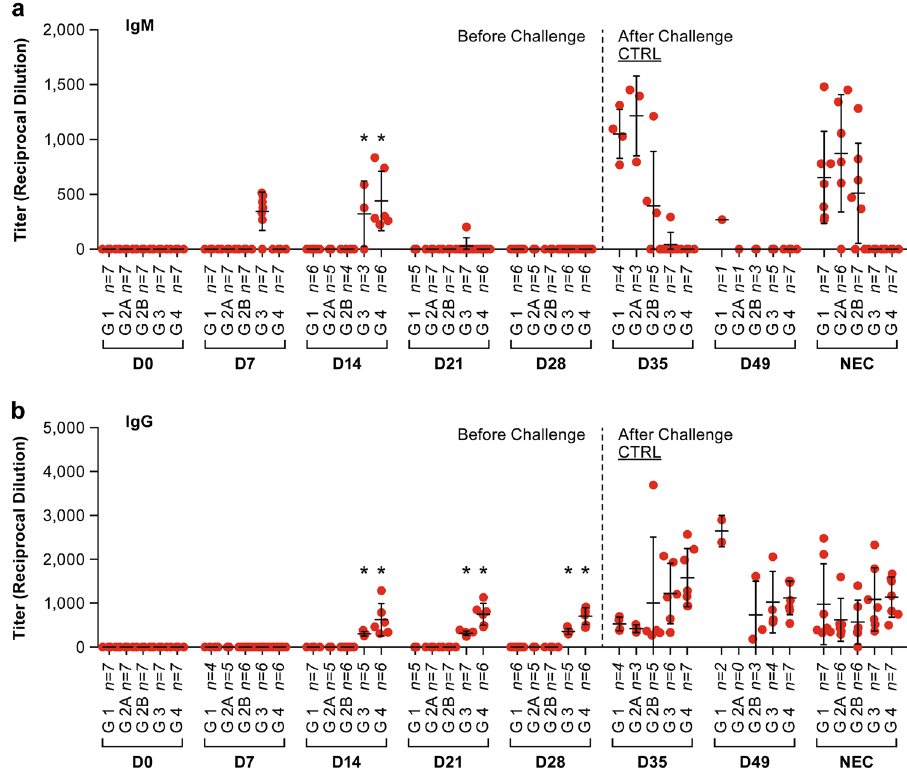
Fig. 5 ELISA titers in serum collected during the single-dose vaccine trial. The panel a shows IgM titers and panel b shows IgG titers at the indicated days post-vaccination. Each marker represents an individual animal. Bars are the mean titer with standard deviation indicated. The (*) indicates a group average statistically ( P < 0.01) greater than the diluent control for the same time point. The ELISA titers were determined based on the serum dilution that gives half-maximal response (EC50) of a 4-parameter logistic (4PL) sigmoidal dose-response (variable slope) curve. The endpoint of the graph was plotted with a 4PL nonlinear regression (curve fi t) of corresponding percent maximal binding values in Y -axis (normalized from OD 450) 50 versus the logarithm of the reciprocal serum dilution ( X -axis) using GraphPad Prism software (version 7, GraphPad Software, La Jolla, CA)